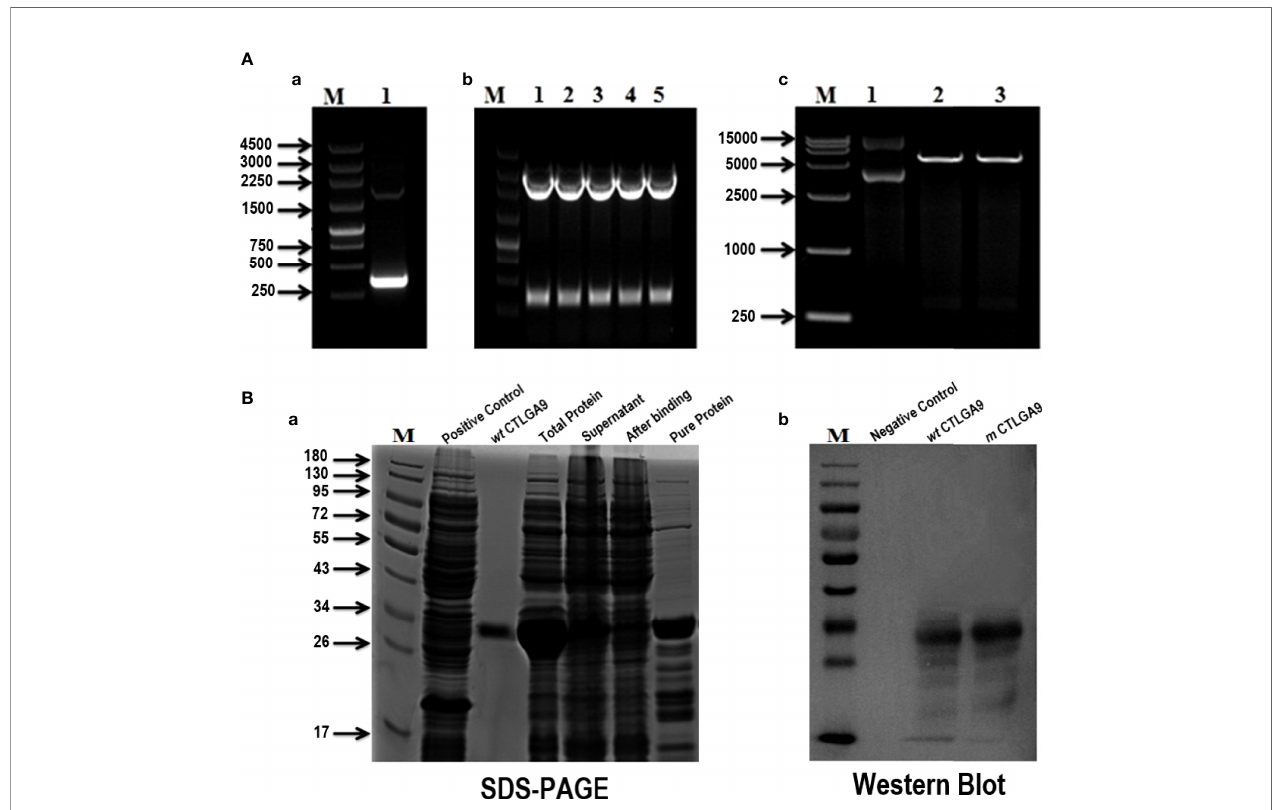
FIGURE 3 | PCR Ampli fi cation of mutant CTLGA9 gene (A-a), Lane M: 250bp DNA marker (Thermo); Lane 1: ampli fi ed fragment of 354bp. (A-b) pMD18T recombinant plasmid digested with NcoI/HindIII , Lane M: 250bp DNA marker; Lane 1-5: plasmid digested product. (A-c) pET32 a harboring m CTLGA9 recombinant plasmid digestion with enzyme sites NcoI/HindIII . Lane M: DL15000bp DNA marker (Thermo), Lane 1: Recombinant plasmid of CTLGA9- pET32 a ; Lane 2, 3: digested product. (B) SDS-PAGE and Western blotting analysis of m CTLGA9. (B-a) Lane M: 180 kDa molecular mass marker, Lane 2: Trx control; Lane 3: wt CTLGA9 protein; Lane 4: total mutant protein; Lane 5: mutant Supernatant; Lane 6: after binding sample; Lane 7: puri fi ed m CTLGA9 protein. (B-b) Western blot of m CTLGA9 protein. Lane M: 180 kDa molecular mass marker (Thermo); Lane 2: Trx control; Lane 3: wt CTLGA9 control protein; Lane 4: m CTLGA9 protein. Proteins were detected through CTLGA9 speci fi c